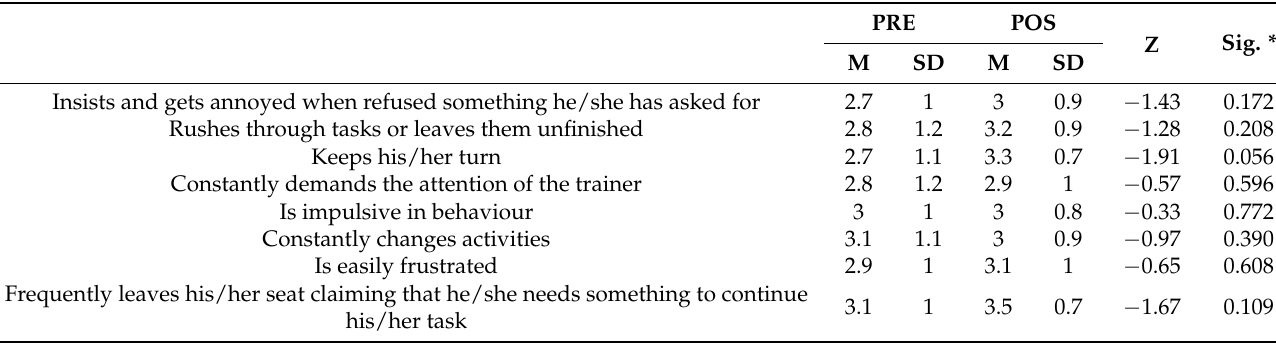
Table 7. Impatience.